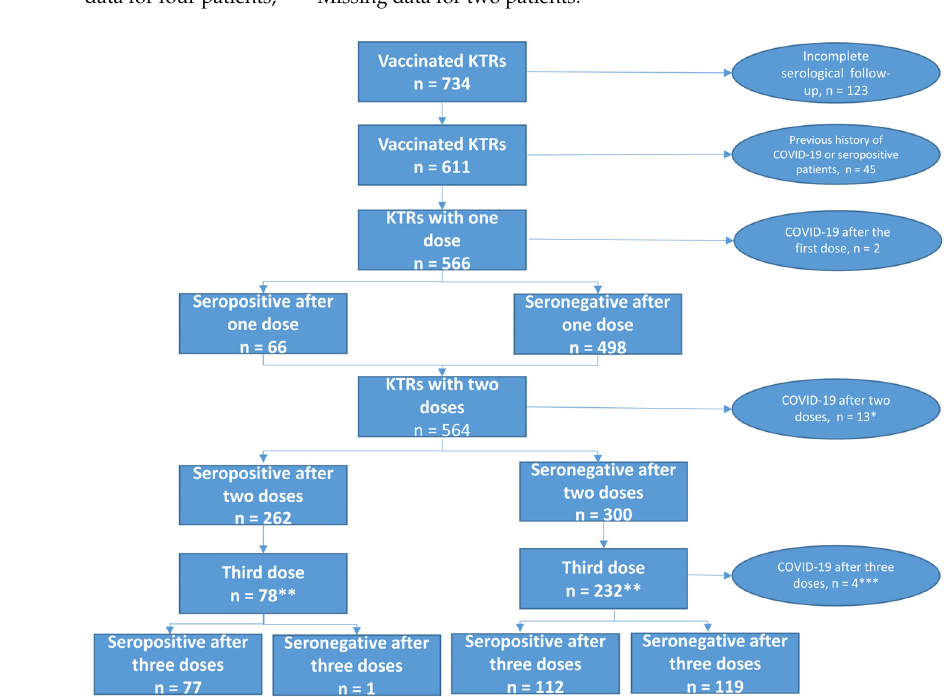
Figure 1. Flow of patients through the study according to the serological response to the mRNA- 1273 (Spikevax; Moderna) vaccine. * Among the 13 patients who developed COVID-19 after the second vaccine dose, one displayed a moderate response (antibody titer: 99 BAU/mL), four were weak responders, and six non-responders. Two KTRs were diagnosed with COVID-19 before the serological assessment within one month and were not included in the analysis. ** Only patients with available serology after the third vaccine dose. *** Among the four patients with COVID-19, two displayed a moderate response and one was a non-responder one month after the third dose. The four patients developed COVID-19 in the month that followed vaccine administration; however, serology was